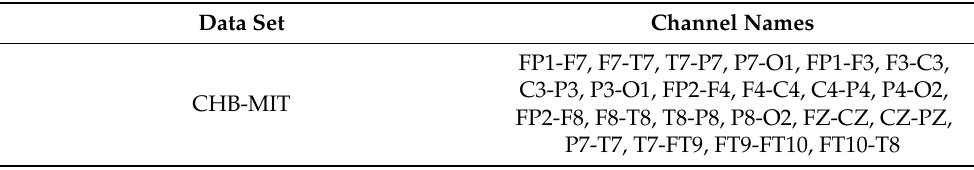
Table A1. List of 22 channels used in the CHB-MIT data set.